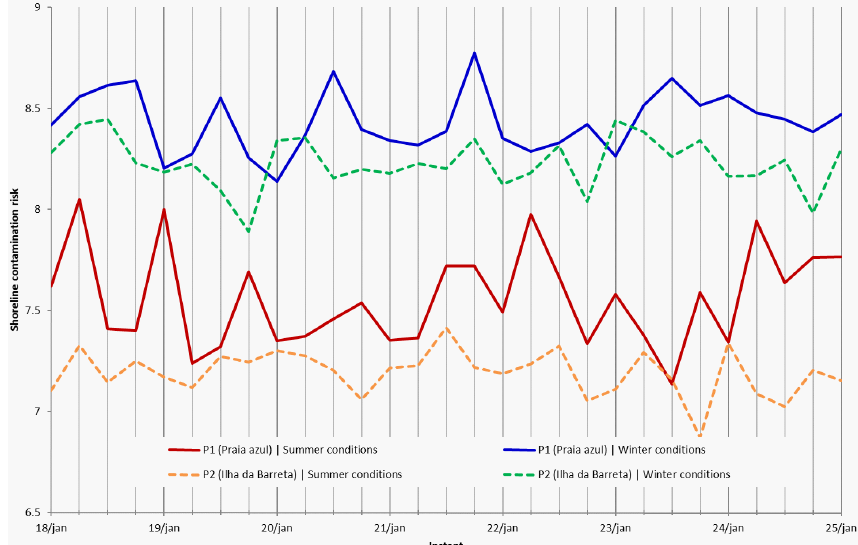
Figure 8. Evolution of shoreline contamination risk in P 1 and P 2 with vessel AIS information obtained between 18 and 25 January 2013, using different space and time constant metocean conditions. Winter/rough conditions: surface current velocity, 0.55ms − 1 ; wind velocity, 15ms − 1 ; significant wave height, 3m. Summer/calm conditions: surface current velocity, 0.25ms − 1 ; wind velocity, 5ms − 1 ; significant wave height,